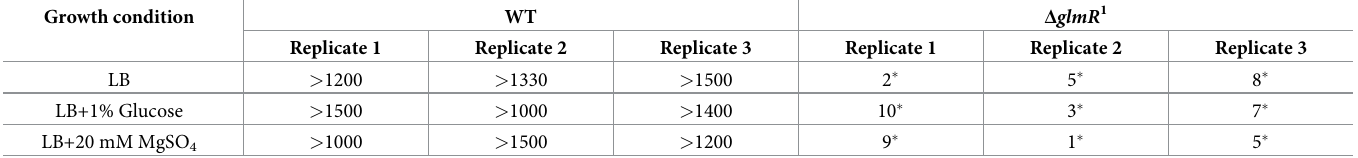
Table 1. Number of colony forming units (CFUs) obtained during transformation of WT and Δ glmR mutant strains with chromosomal DNA containing pgcA :: mls . Growth